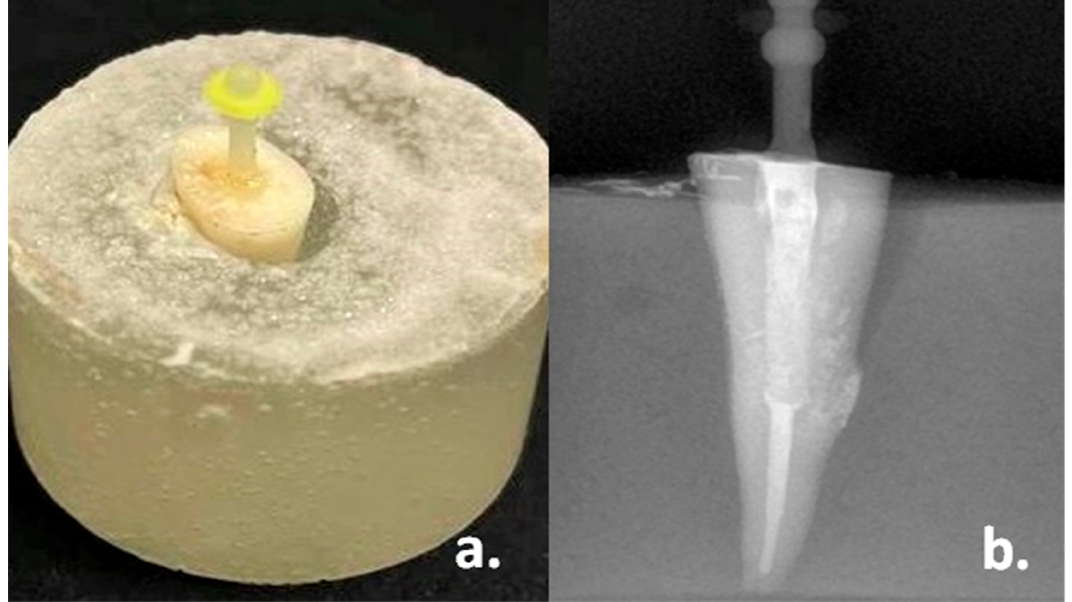
Figure 3. ( a ): Photograph of the specimen after cementation of post; ( b ): Radiograph of the specimen after cementation of post.